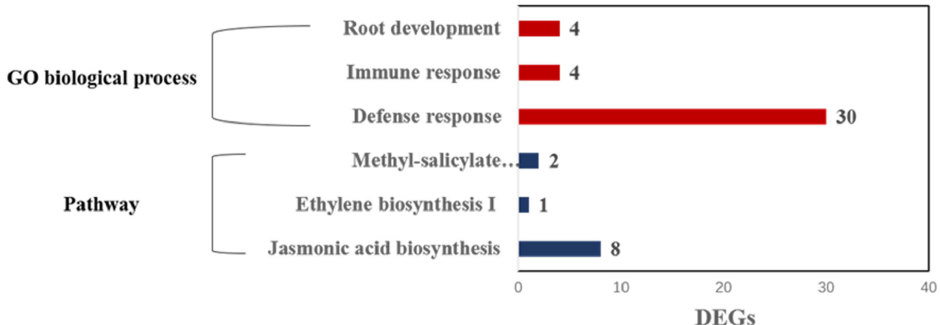
Figure 5. Visualization of number of differentially expressed genes in pea resistant or susceptible to Aphanomyces root rot based on the GO biological process, including root development (GO:0010015, GO:0010053, GO:0022622 and GO:0048364), immune response (GO:0006955) and defense response (GO:0006952, GO:0031347 and GO:0031348), as well as signaling pathways involving salicylate acid, ethylene and jasmonic acid.